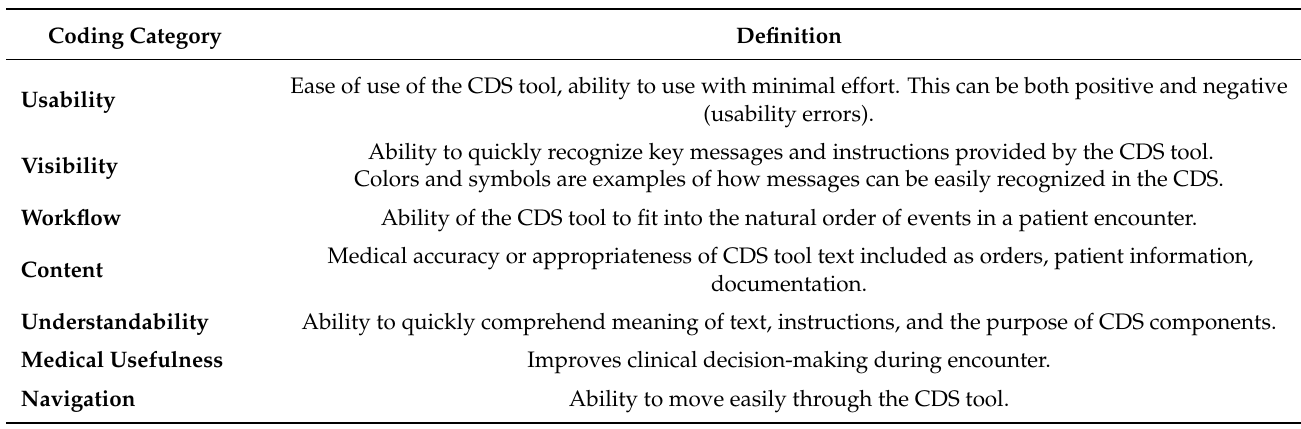
Table 1. Codebook used during the “Think Aloud” session to help categorize the statements the healthcare providers provided on the two